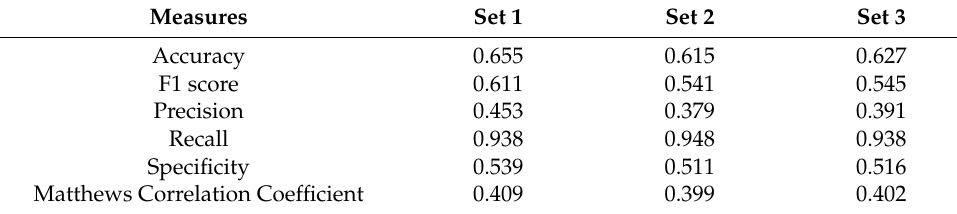
Table 2. Effectivity of Naïve Bayes model for recognition of troll users in online